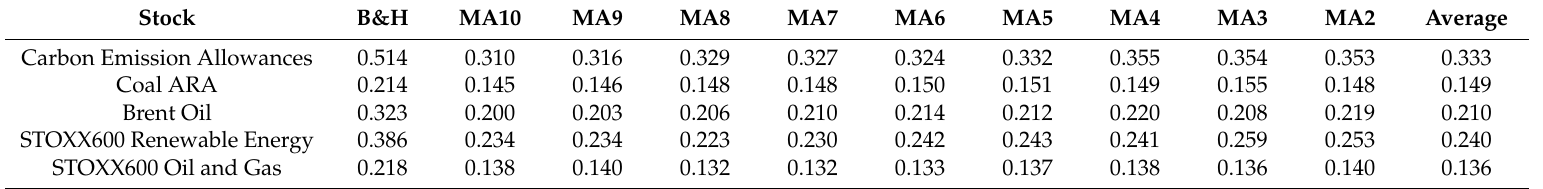
Table A10. Annualized daily (every 22nd trading day) volatility of MA2–MA10, average annualized volatility.